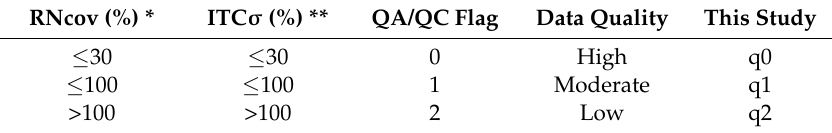
Table 2. Overall quality flags of the EddyPro 6.2 software used in the turbulence